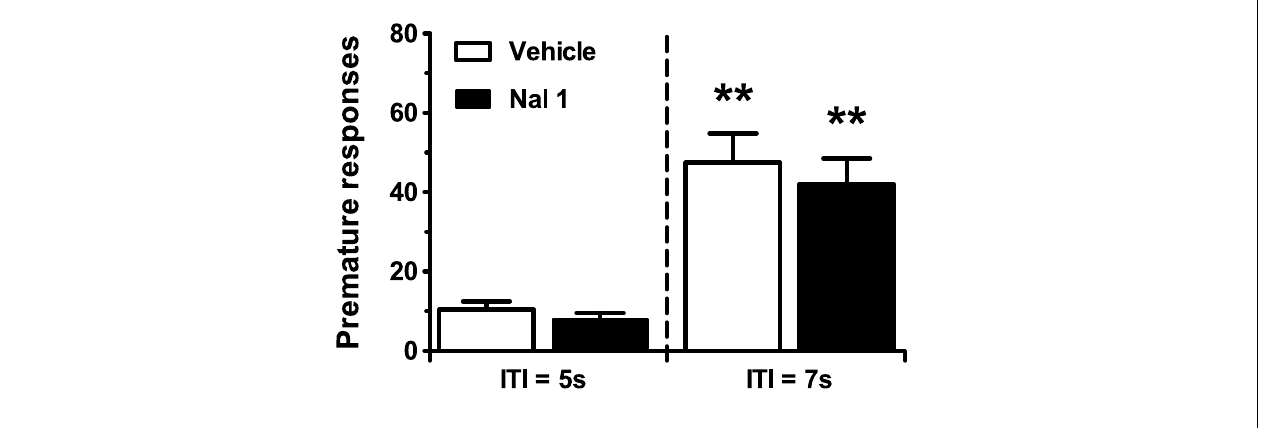
premature responses made in the 5-CSRTT under conditions of normal or lengthened ITI. In total n = 16 rats were included in the analyses. Drug doses are expressed as mg/kg. ** p < 0.005 versus respectiveVehicle control.